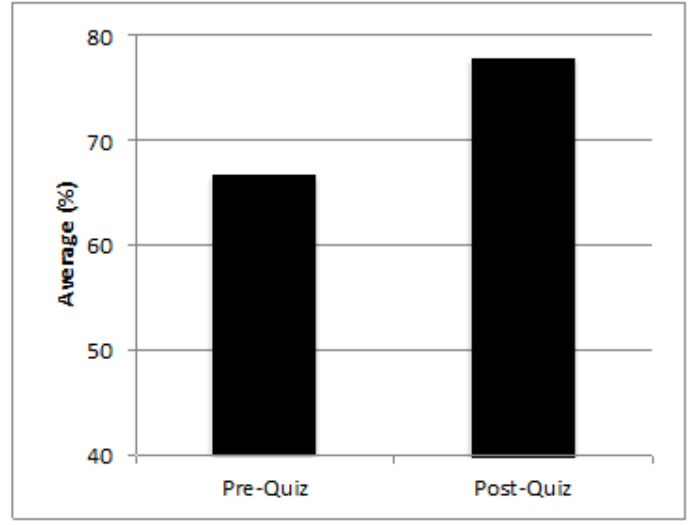
Figure 12. The overall average for the experimental group for the question regarding drawing a parallel diagram